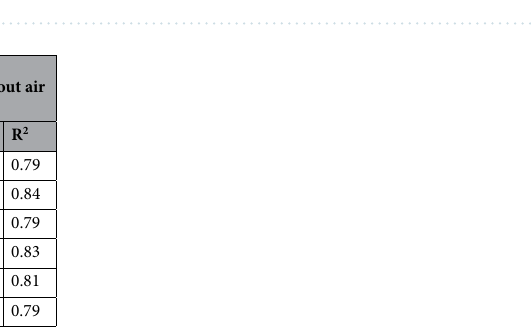
Figure 8. PM2.5 prediction result curves (with air pollutants vs. without air pollutants). ( a ) Binzhou, ( b ) Jinan, ( c ) Handan, ( d ) Taiyuan, ( e ) Xinxiang and ( f ) Zibo.